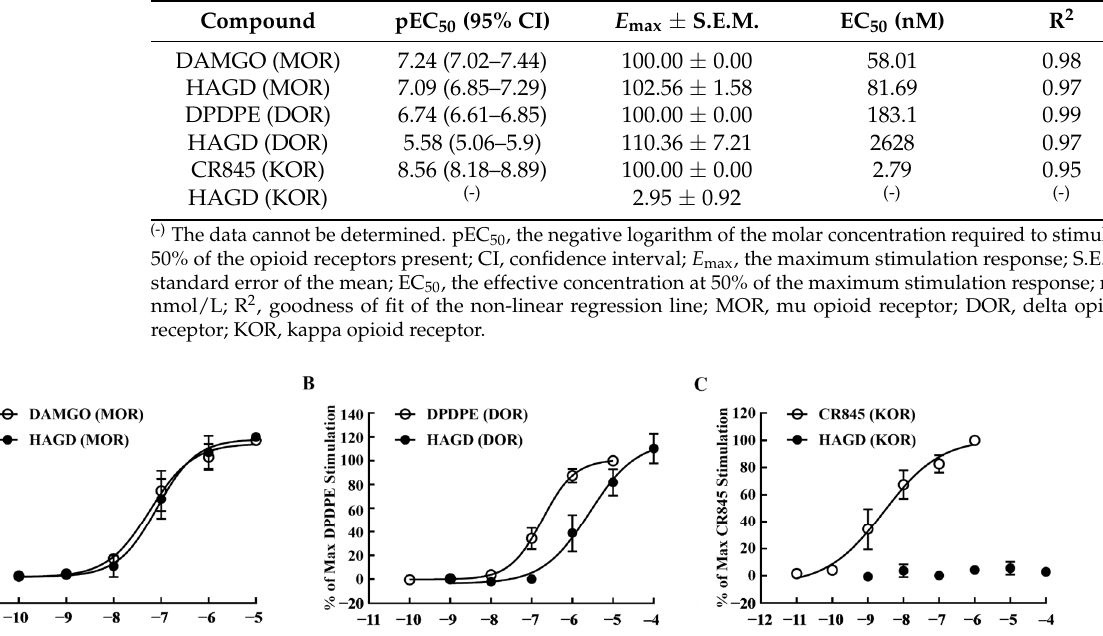
Table 1. The agonist efficacy of HAGD in calcium mobilization assays. Compound